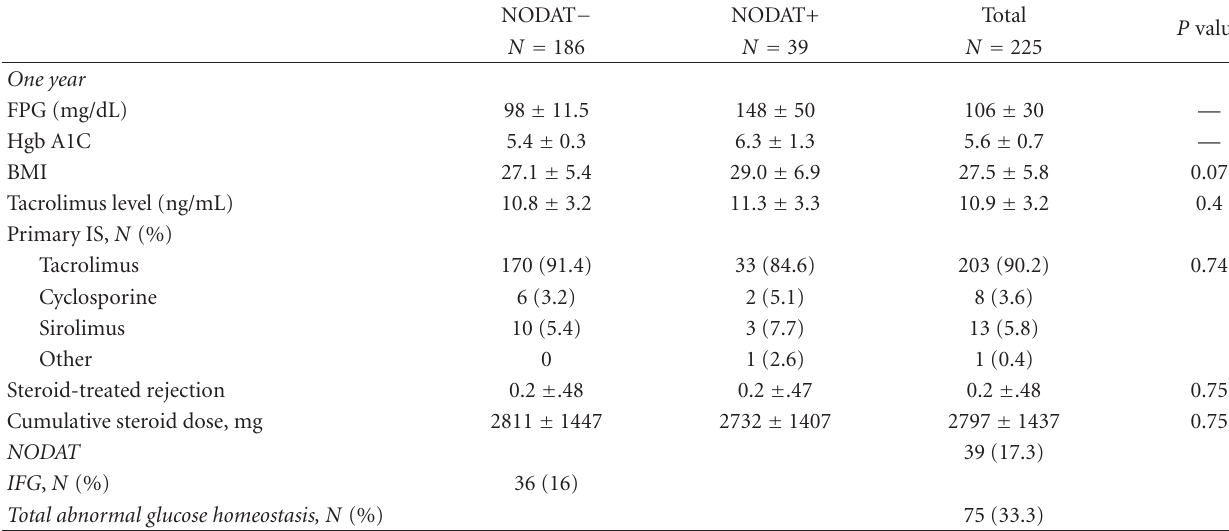
Table 3: Posttransplant variables by development of NODAT.